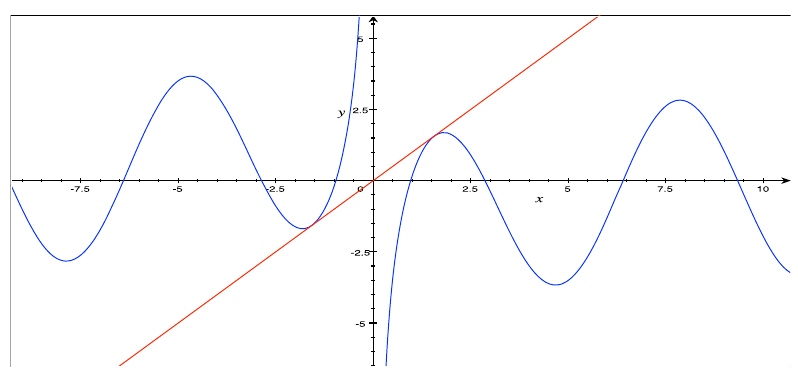
Figure 13: Graph of f